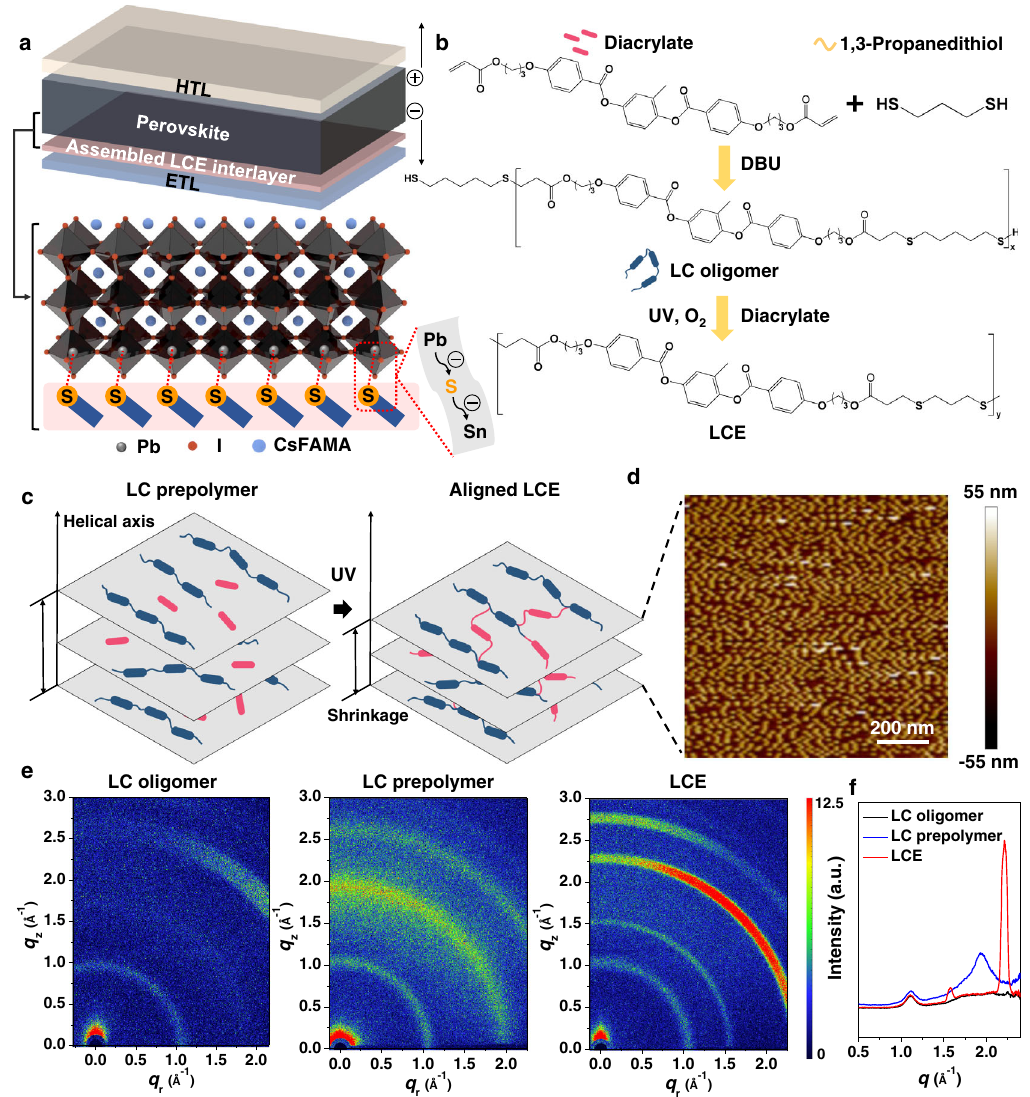
Fig.1|SynthesisandcharacterizationofLCE.a SchematicillustrationoftheLCE- assistedPSCwithanassembledLCEinterlayerintercalatedbetweentheperovskite absorber and the ETL layer. b Synthetic route of LCE. c Schematic illustration of aligned-LCE assembled via photopolymerization from randomly orientated LC